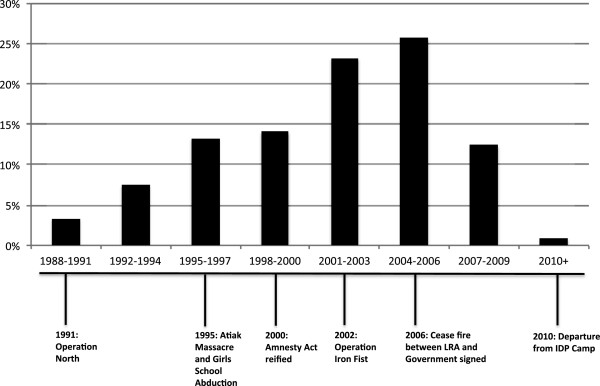
Variation in abduction frequencies over the historical timeline of the war.